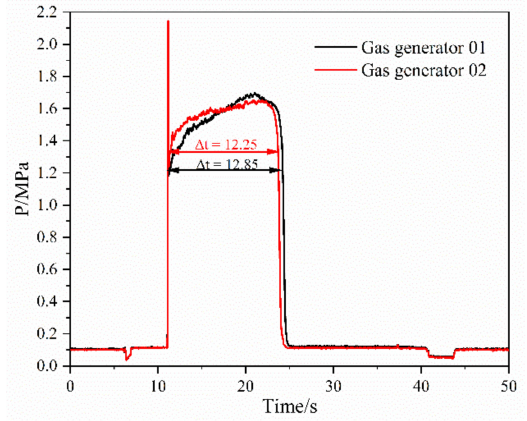
Figure 7. Evolution of pressure of in the gas generator during the test.